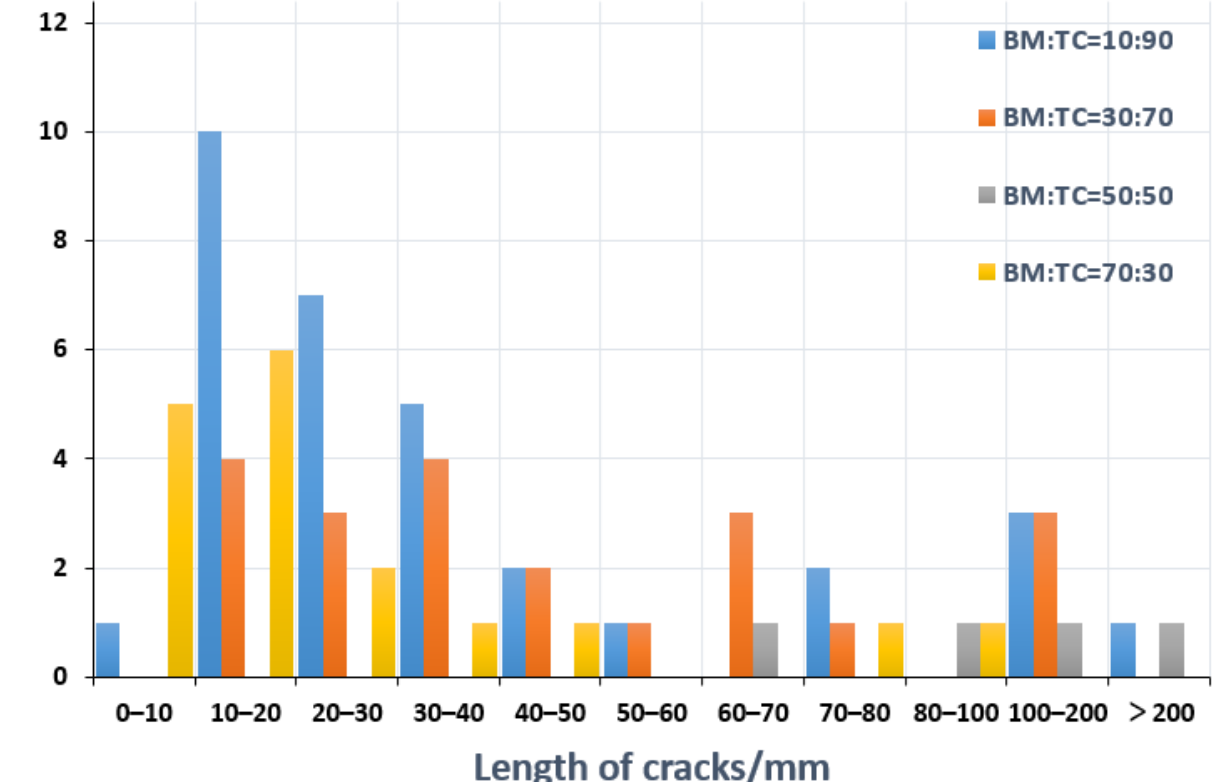
Figure 8. Desiccation crack morphology under different K:S (K:S refers to the ratio of kaolin to smec- tite minerals) conditions. In the figure, from left to right are S1, S5, S6, and S7, respectively. ( a ) 20% kaolin, 80% smectite. ( b ) 40% kaolin, 60% smectite. ( c ) 60% kaolin, 40% smectite. ( d ) 80% kaolin, 20% smectite. (The diameter of the sample is 24 cm).